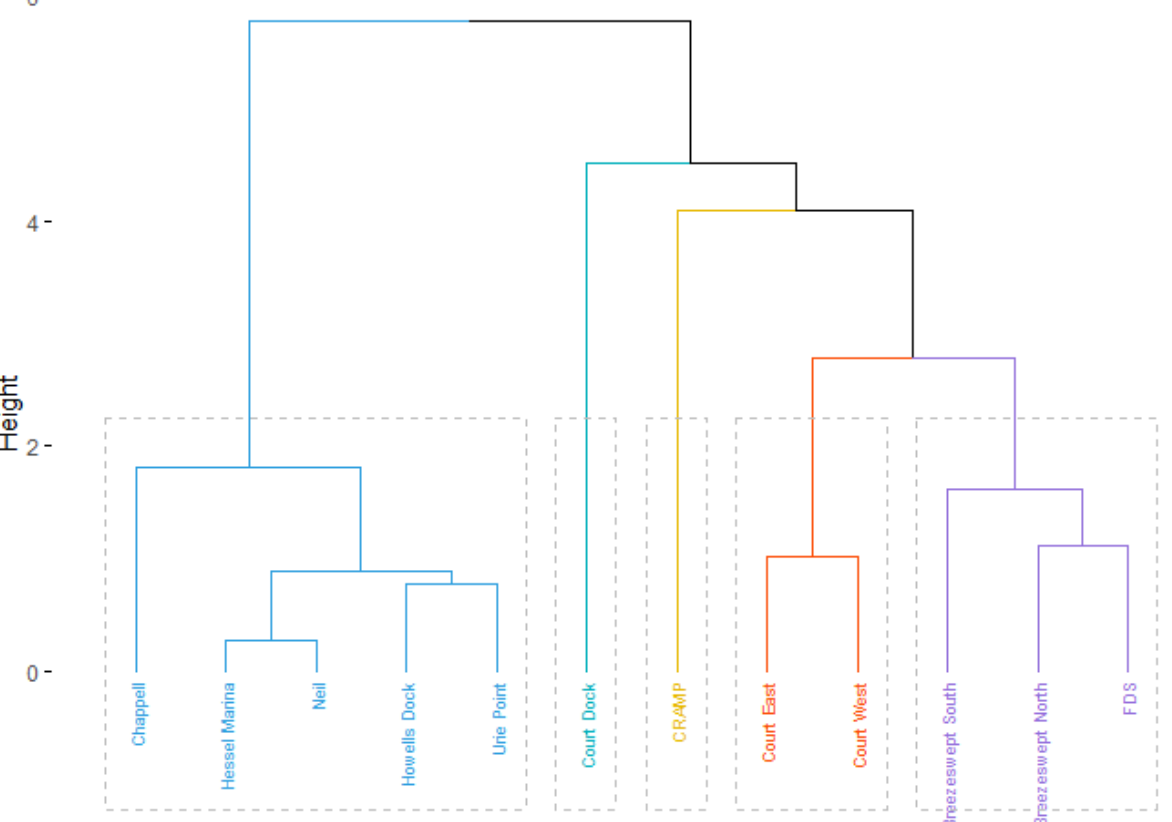
Figure 4. Dendrogram results for site clustering; sites with higher water clarity have clustered on the left (in light blue) that we subsequently called Type A sites, while lower water clarity sites form multiple clusters but all within the second branch that we called Type B sites.